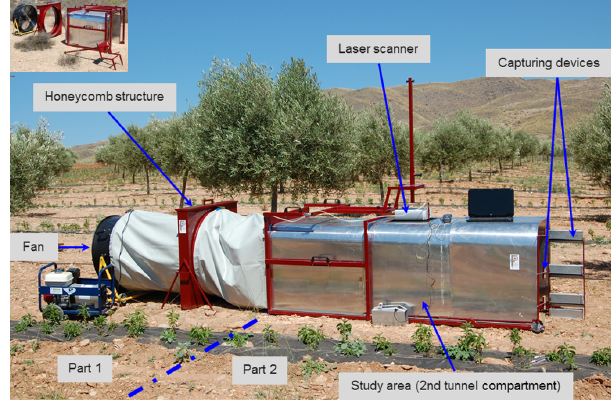
Figure 1. Details of the wind tunnel